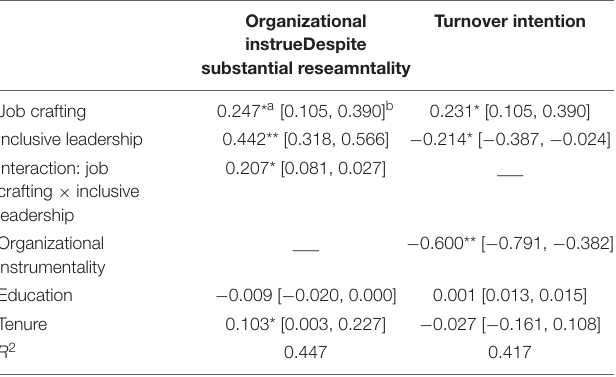
TABLE 2 | Path coefficients for the moderated mediation